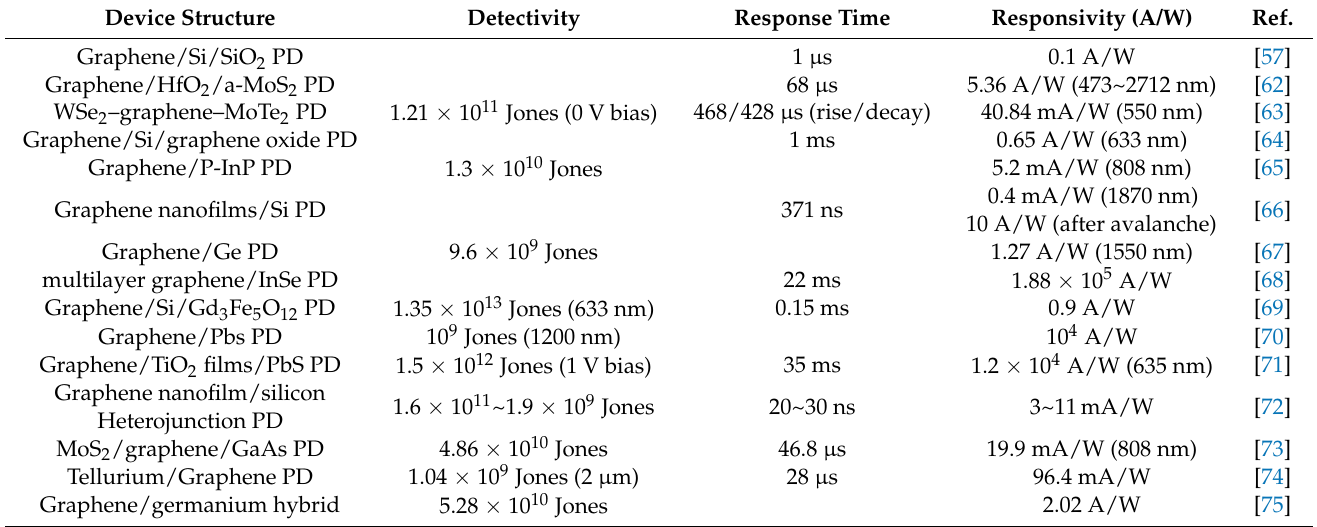
Table 1. PDs based on